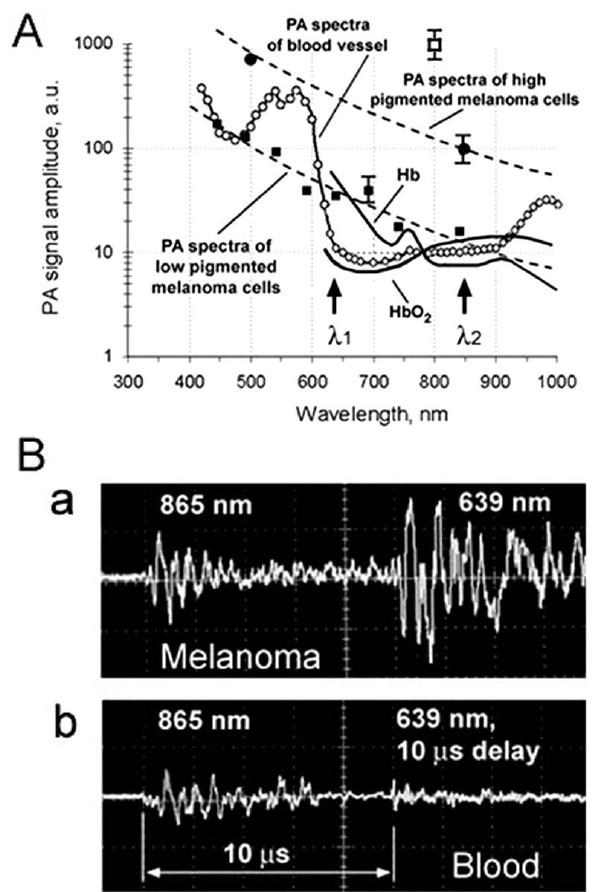
Figure 10. ( A ) PA spectra of ~50 μ m diameter veins in mouse ear ( empty circles ); the average standard deviation for each wavelength is 20%. The absorption spectra of the B16F10 cells ( dashed curves ) were normalized to PA signals from single melanoma cells with strong ( black circle ) and weak ( dark square ) pigmentation; open square indicates signal from melanoma cell with GNRs; fragment of solid curves shows absorption for 100% of hemoglobin and oxyhemoglobin; ( B ) Real-time two-color PAFC ( λ = 865 nm) to identify melanoma CTCs among λ 2